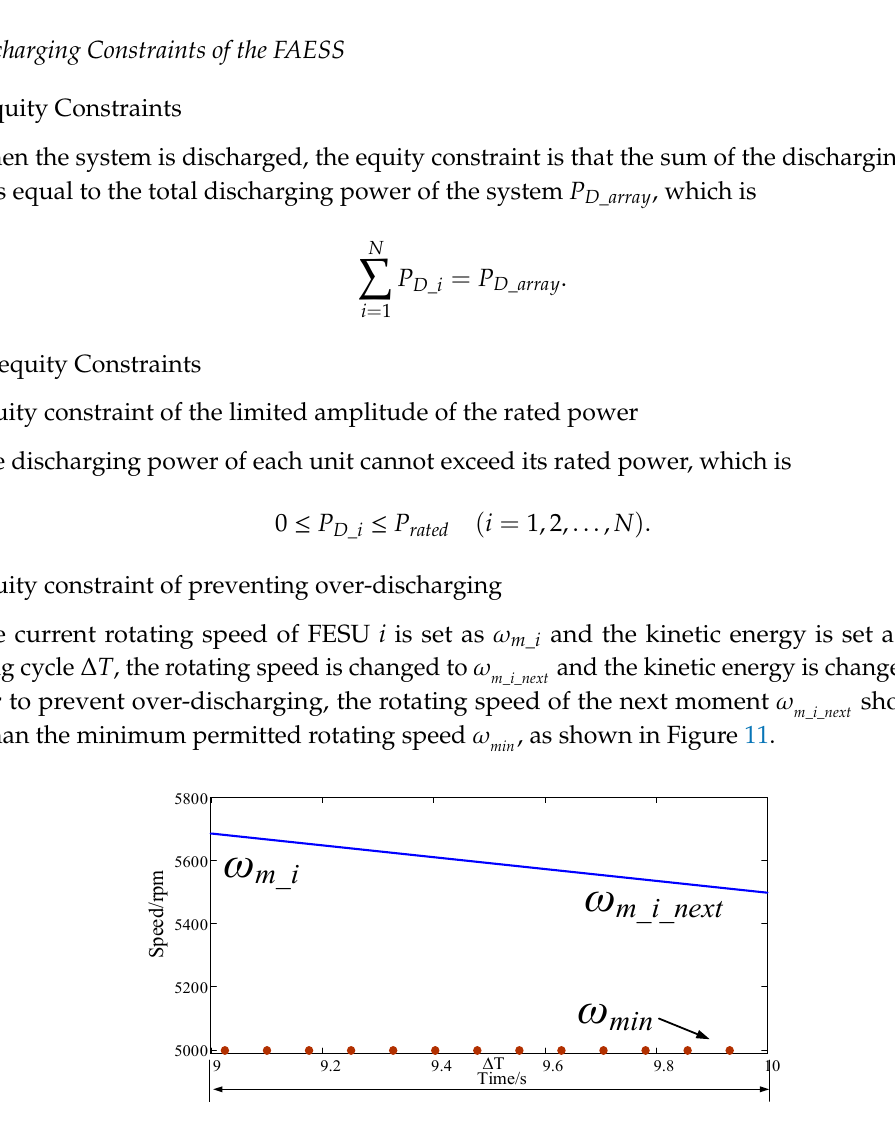
Figure 11. Prevention of over-discharging.